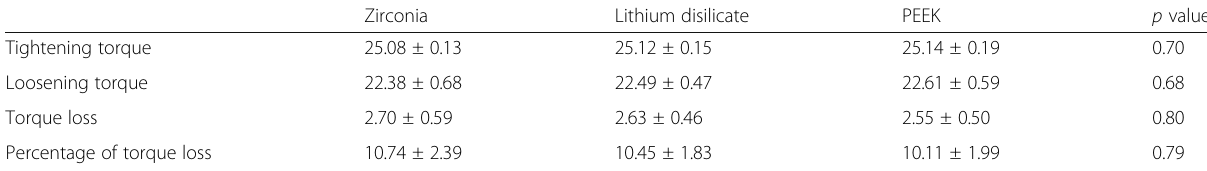
Table 1 Comparison between zirconia, lithium disilicate, and PEEK hybrid-abutment-restorations regarding tightening torque (Ncm), loosening torque (Ncm), torque loss (Ncm), and percentage of torque loss (%)